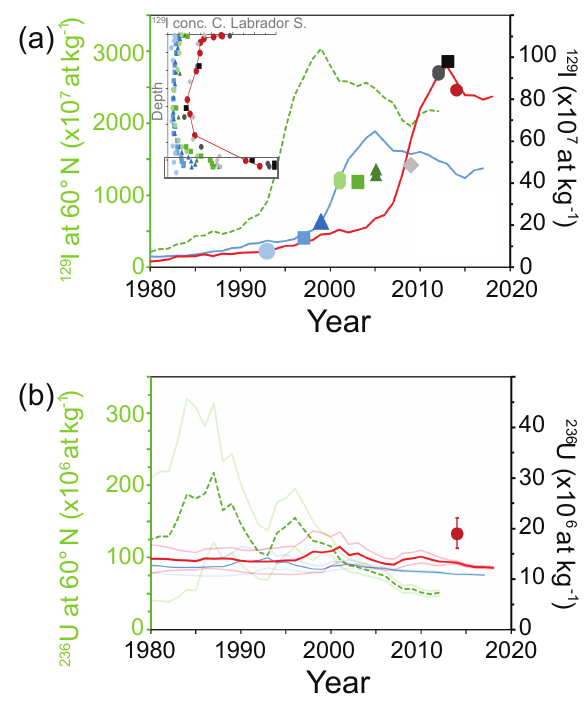
Figure 6. Comparison between measured (data points) and simu- lated (lines) radionuclide concentrations in bottom waters (DSOW) at the central Labrador Sea for (a) 129 I and (b) 236 U. The green y axis on the left represents radionuclide concentrations over time (or the radionuclide input functions, also in green) at 60 ◦ N due to releases from the European nuclear reprocessing plants and which were reported by Christl et al. (2015b). Note that for 236 U, the av- erage input function is accompanied with a lower and upper bound estimate to acknowledge the current uncertainties on the 236 U re- leases from Sellafield and La Hague (Christl et al., 2015b). The black y axis on the right represents radionuclide concentrations, measured or simulated, in bottom waters of the central Labrador Sea. On these axes are the blue and red lines that represent two versions of the radionuclide input function at 60 ◦ N after dilution (DF = 50 and 30) and application of a time delay (6 and 14 years) that corresponds to the transport from 60 ◦ N to the central Labrador Sea. The blue and red simulations include background concentra- tions for 129 I (2 . 5 × 10 7 atkg − 1 ; Edmonds et al., 2001) and 236 U (10 × 10 6 atkg − 1 ; e.g. Christl et al., 2012) due to the global fall- out. On the black y axis are also the radionuclide concentrations measured in 2014 that correspond to the bottom sample collected in GEOVIDE station 69. Earlier data on 129 I concentrations at sim- ilar locations were reported for 1993 by Edmonds et al. (2001); for 1997, 1999 and 2001 by Smith et al. (2005); for 2003, 2005 and 2009 by Orre et al. (2010); and for 2012 and 2013 by Smith et al.